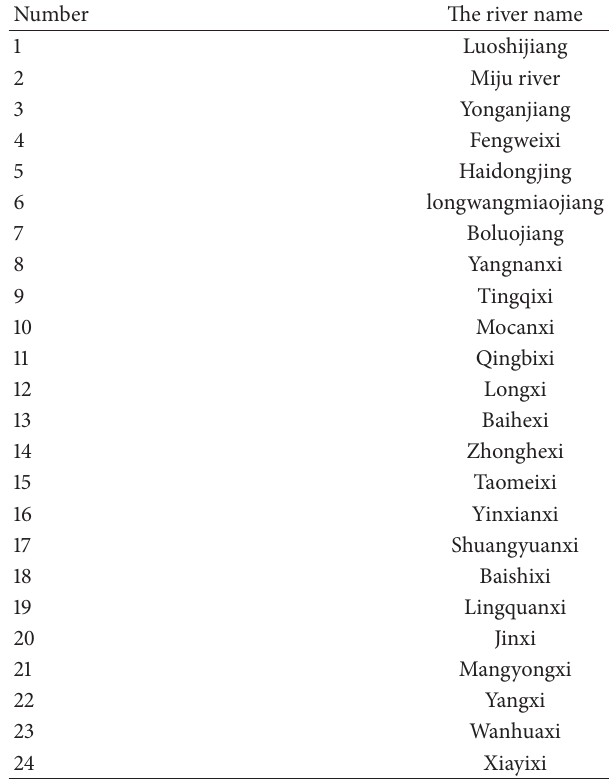
Table 1: Main rivers into Erhai Lake in Erhai